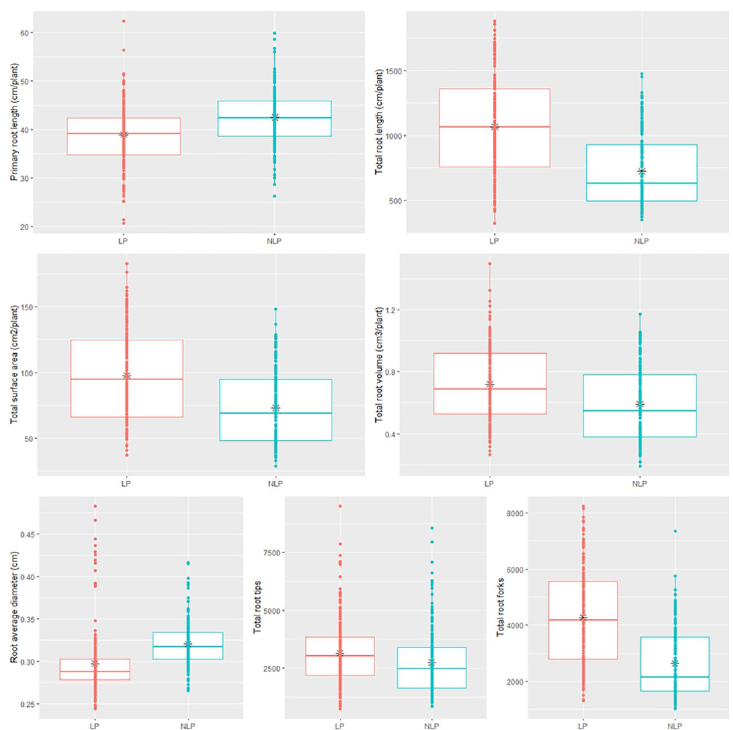
Fig 1. Box plot showing the median and range of phenotypic variation in wheat genotypes in non-limiting and limiting phosphorus conditions.